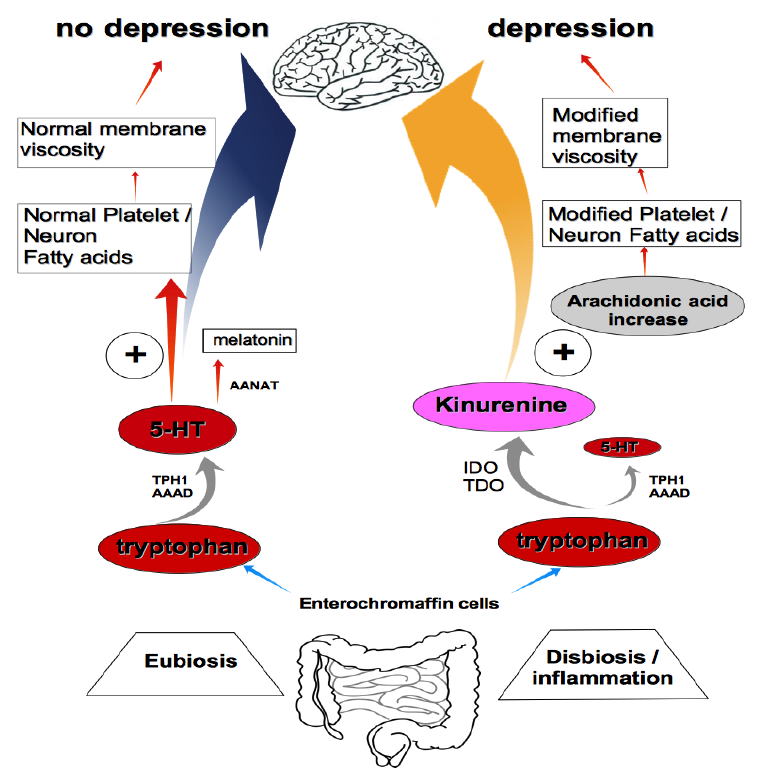
Figure 2. Tryptophan pathway from gut to brain. On the left, a schematic description of the metabolic pathway of tryptophan from enterochroma ffi n cells to platelets is shown under normal conditions. To the right, the same hypothetical pathway is modified in conditions of intestinal inflammation or dysbiosis (loss of stability of gut microbiota) and under an alteration in the fluidity of the membrane due to the excessive presence of arachidonic acid. In this case, 5-HT would not be captured by platelets and would remain free, thus contributing to possible cardiovascular and bone damage. In addition, the enzymes IDO and TDO metabolize tryptophan to kinurenine and, furthermore, stop tryptophan from entering the brain. AAAD, aromatic L-amino acid decarboxylase; AANAT, N-acetyl transferase; IDO, indoleamine 2,3-dioxygenase; TDO, tryptophan 2,3-dioxygenase; 5-HT, 5-hydroxytryptamine, serotonin; TPH1, tryptophan hydroxylase